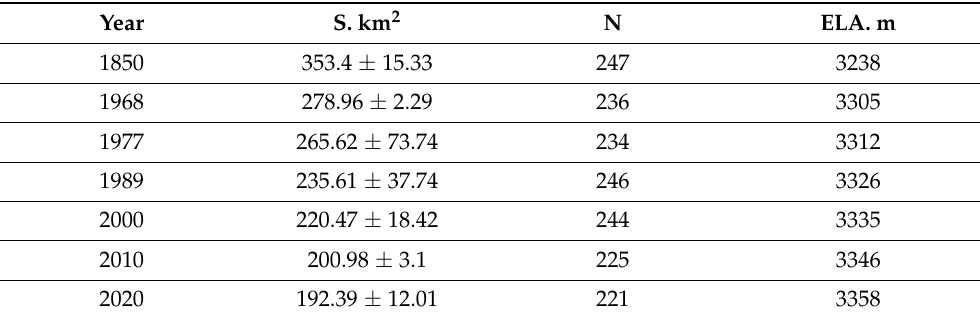
Figure 9. The increase of the ELA after the maximum of the LIA in the southern part of Altai. The numbers of the glacial centers correspond to the ones in Figure 1, Tables 2 and 3. Table 6. The general information about the glaciers of Tavan Bogd at different time points beginning from the LIA maximum.